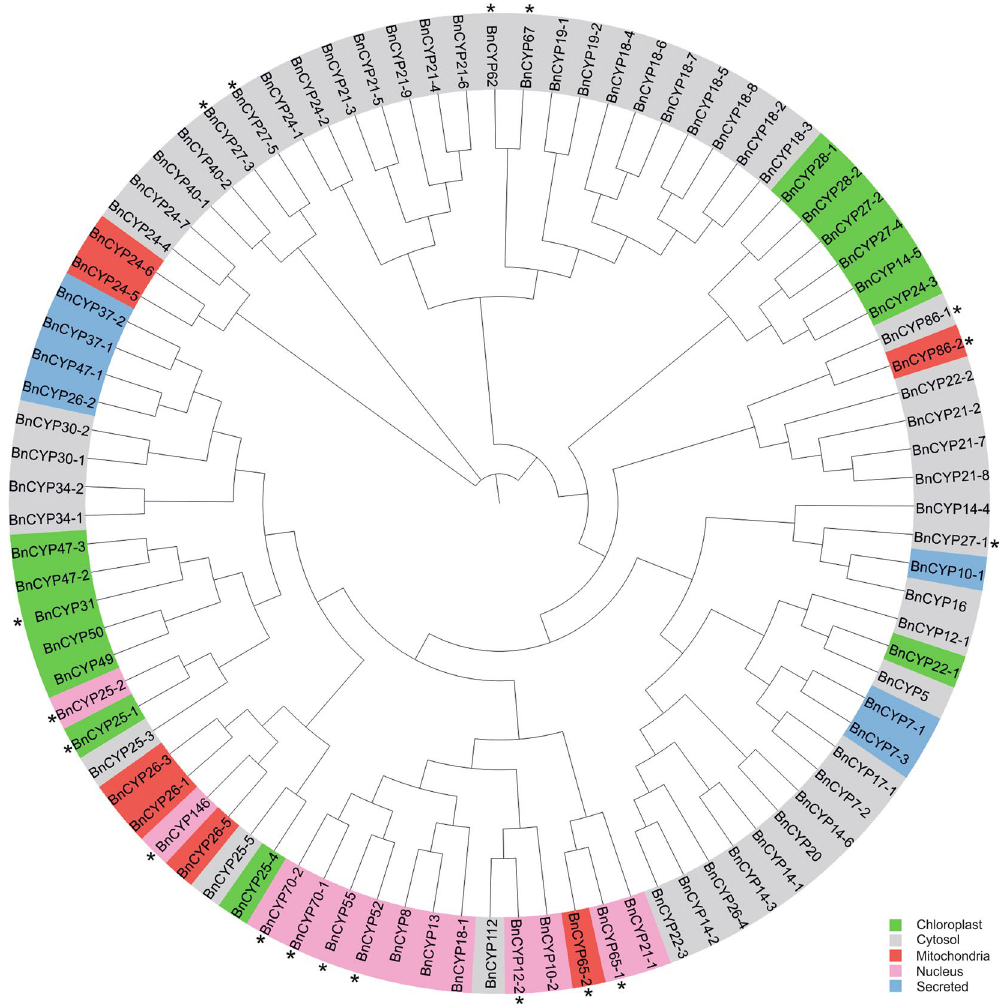
Figure 3. Phylogenetic tree of B. napus cyclophilins. The phylogenetic analysis was based on a sequence alignment by ClustalOmega and constructed as described in Materials and Methods with ignored branch lengths. As indicated by colour code, this protein family is distributed over all intercellular organelles. In addition, some BnCYPs possess putative nuclear localization signals (marked by *